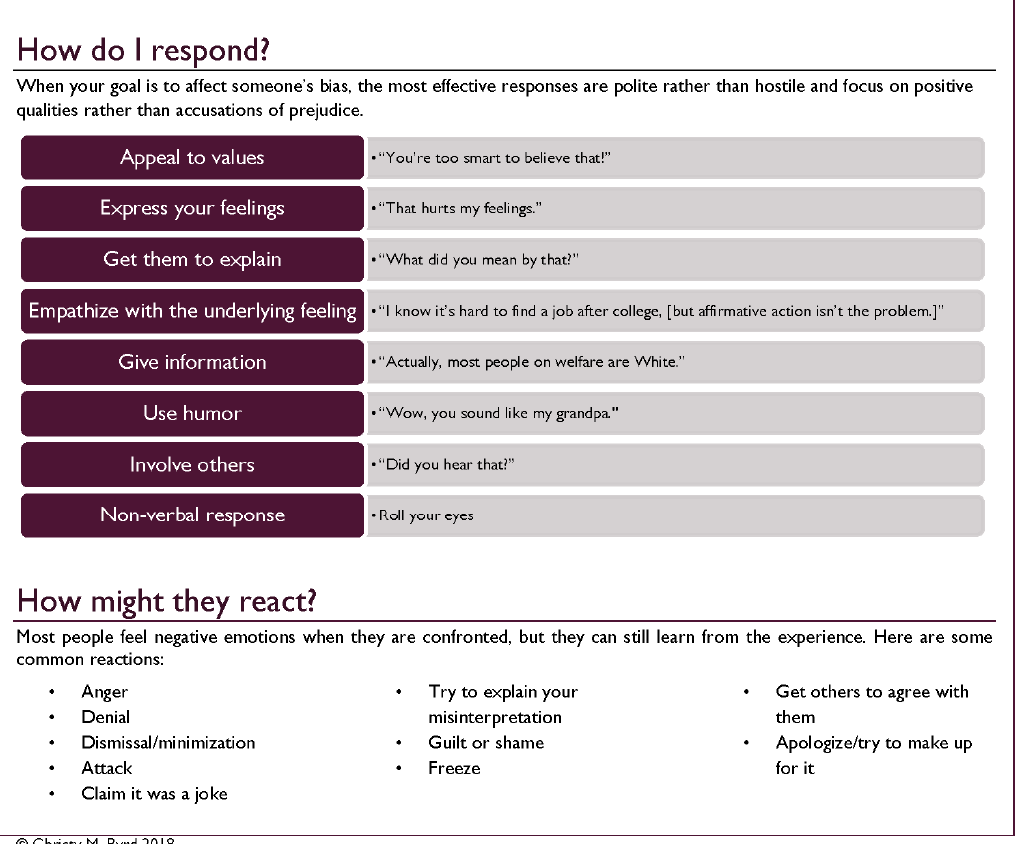
Figure A1. Workshop Handout.